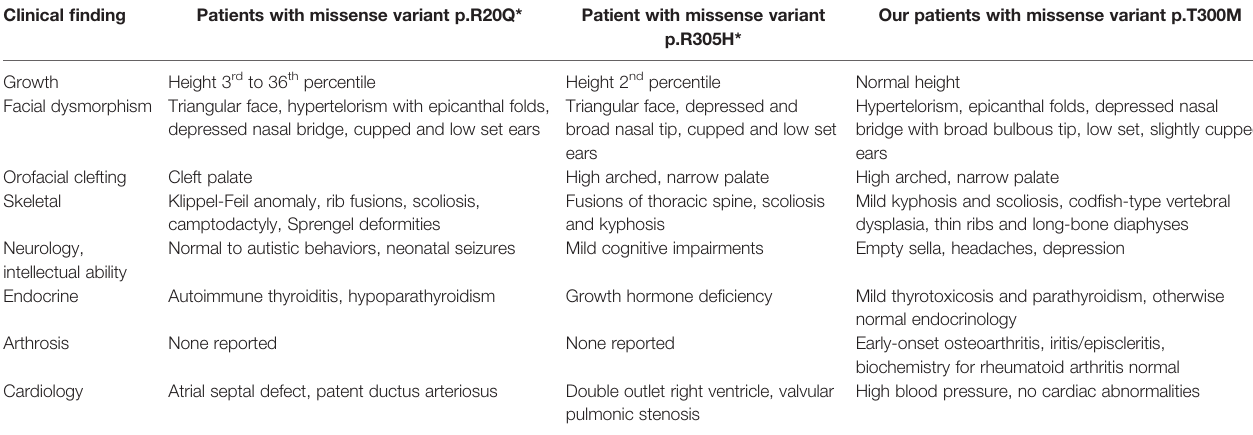
TABLE 2 | Clinical characteristics in the three Finnish patients with a novel skeletal dysplasia, compared with previously reported fi ndings in TBX2 mutation-positive individuals. Clinical fi nding Patients with missense variant